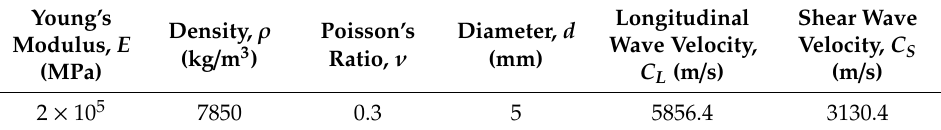
Table 1. Material characteristics of high-strength steel wire.